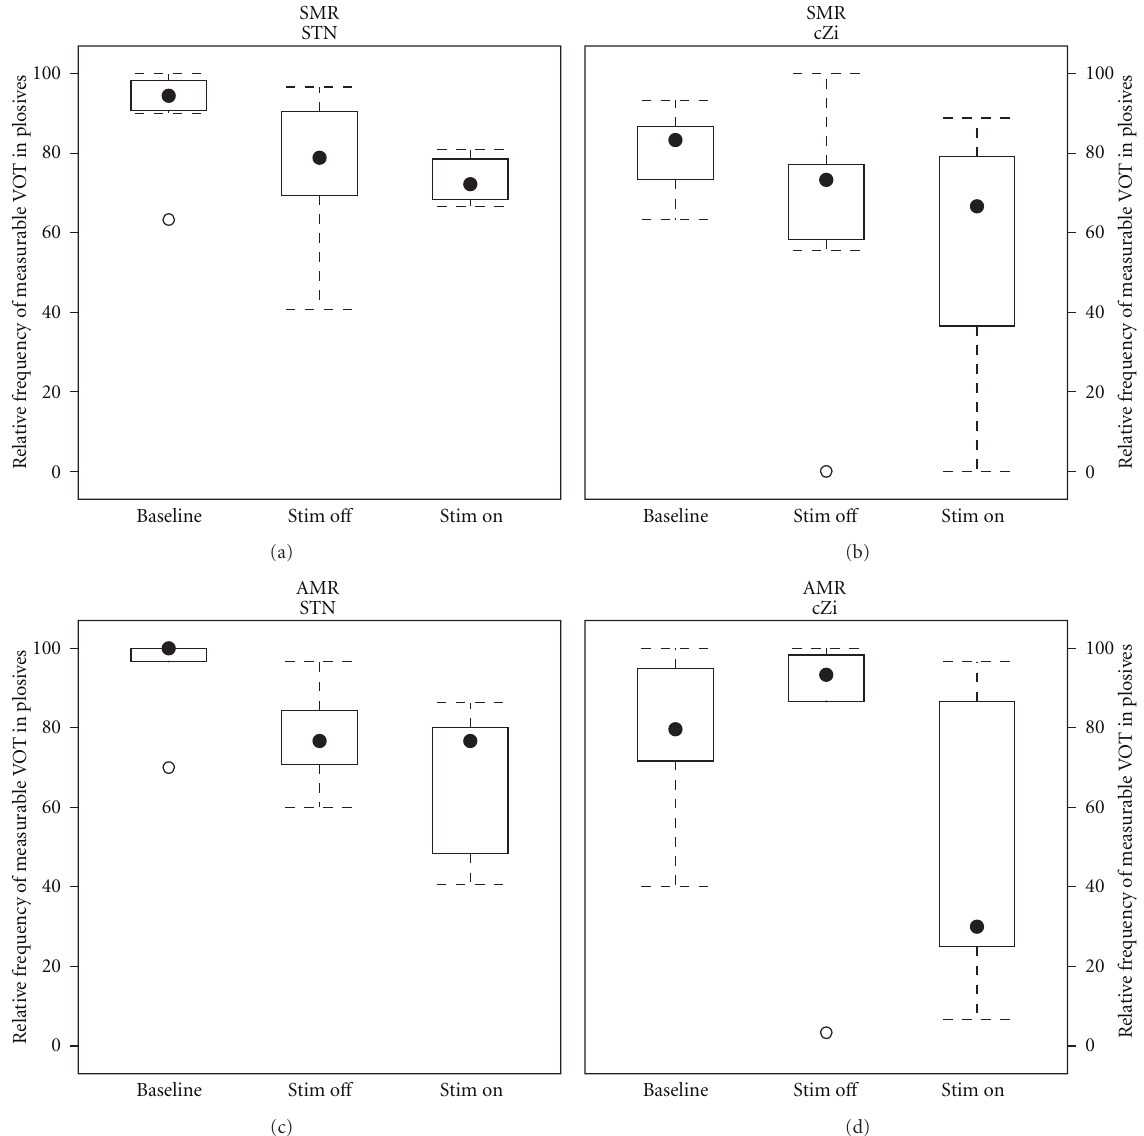
Figure 2: Relative frequency of measurable VOT in plosives produced under the three stimulation conditions for the two investigated patient groups and speech